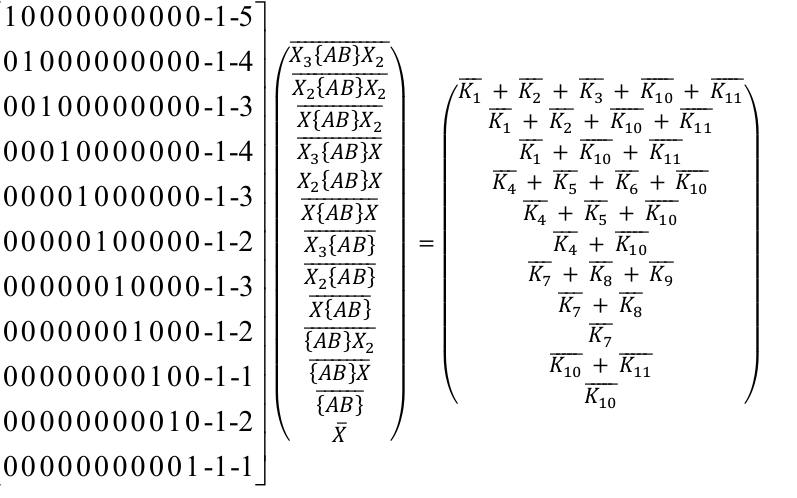
Using this solution we can express the concentrations of the X m { AB } X n species as reported in Table A1. [ X ] is considered to be a parameter, while the concentration C 12 = {(cid:1827)(cid:1828)} can be determined for the condition that in a closed system the total concentration of the X m { AB } X n species, which we name A 0 , is constant, a fact which we express in Equation (A3) as follows: